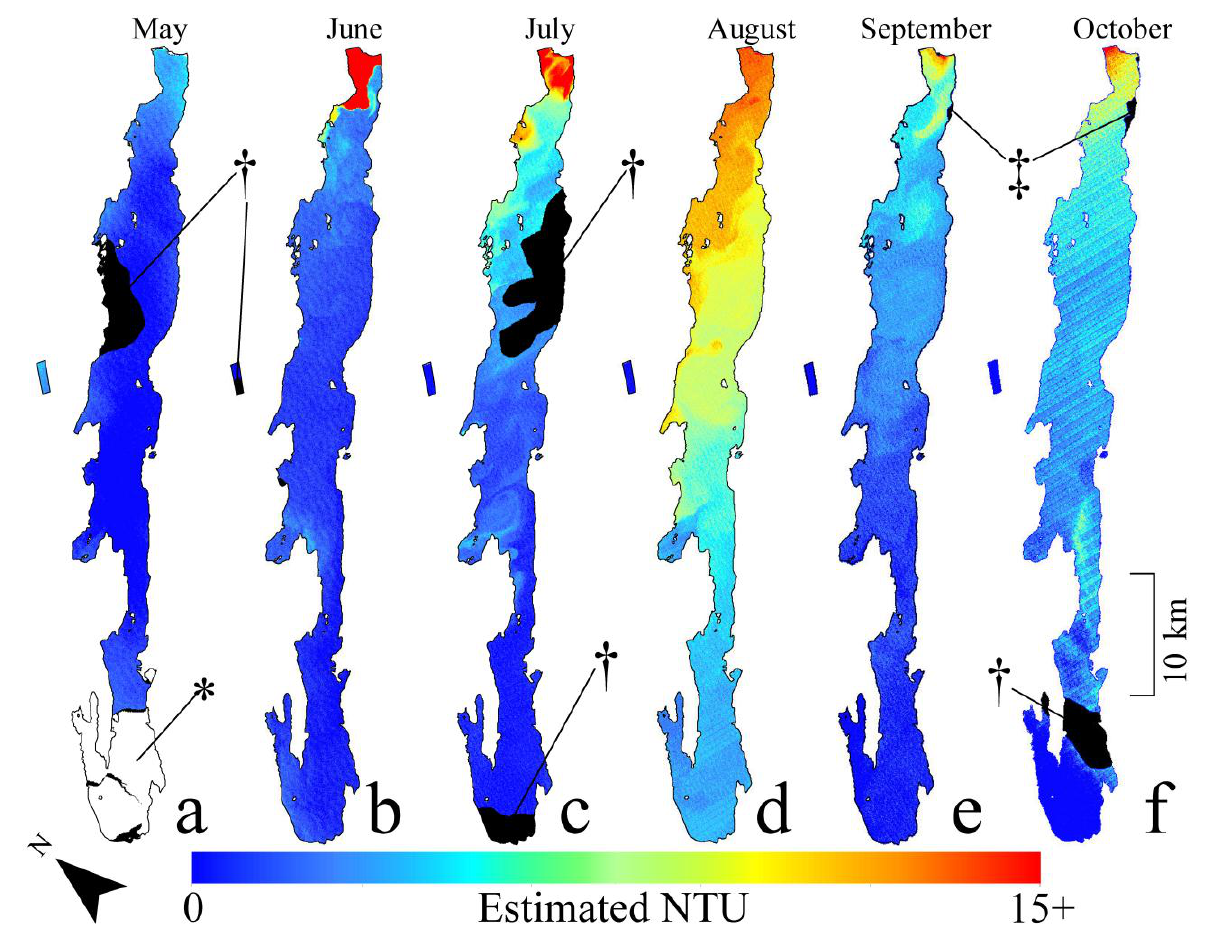
Figure 7. Characteristic spatial patterns of lake-wide turbidity estimated from Landsat images acquired during the study period. ( a ) May 10, 2000: Whole-lake mean NTU E = 2.45. ( b ) June 17, 2002: Mean NTU E = 6.40. ( c ): July 20, 2011: Gyres are visible in the middle basin. Mean NTU E = 6.86. ( d ) August 30, 1991: Mean NTU E = 9.83. ( e ) September 19, 2010: Mean NTU E = 7.34. ( f ) October 5, 2010: Shadows cast by mountains are visible in ( e ) and ( f ) and are common in late season scenes. All Figures: A subset of Kijik Lake, used in dark object subtraction, is consistently sediment free. * = Lake ice, † = Cloud shadow, ‡ = Mountain